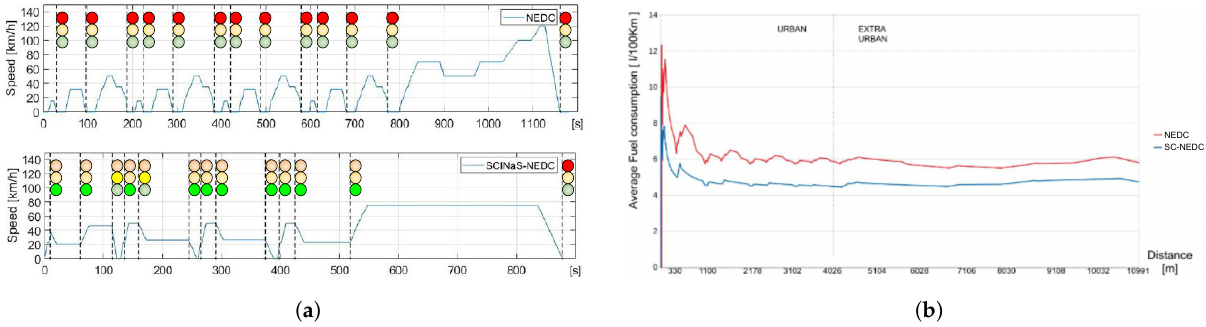
Figure 16. Reduction of traversing time ( a ) and fuel consumption ( b ) when an effective cooperation among city and vehicles is put in